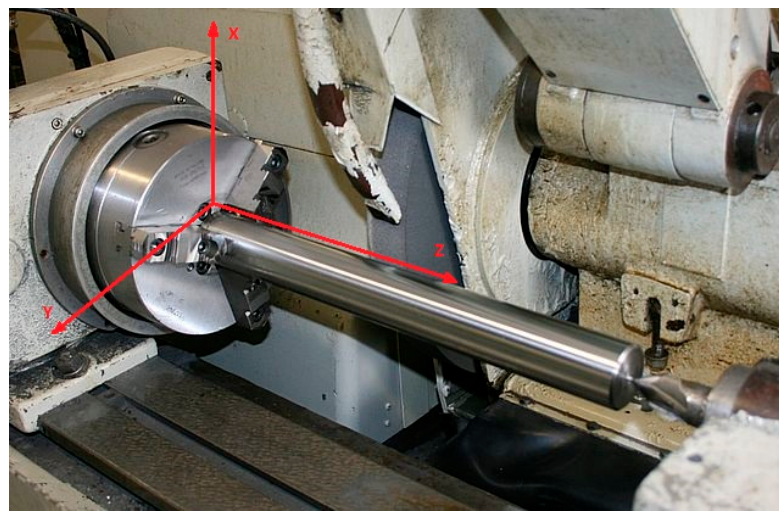
Figure 1. A schematic view of the grinding process with the defined coordinates.